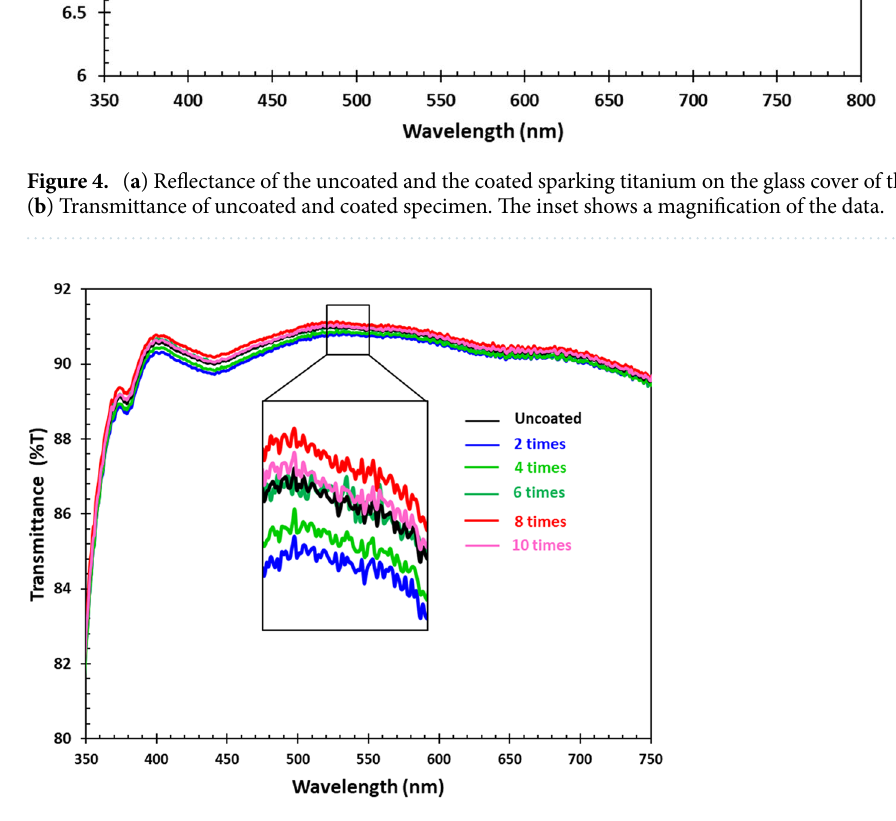
Figure 5. Transmittance of uncoated and coated specimen. The inset shows a magnification of the